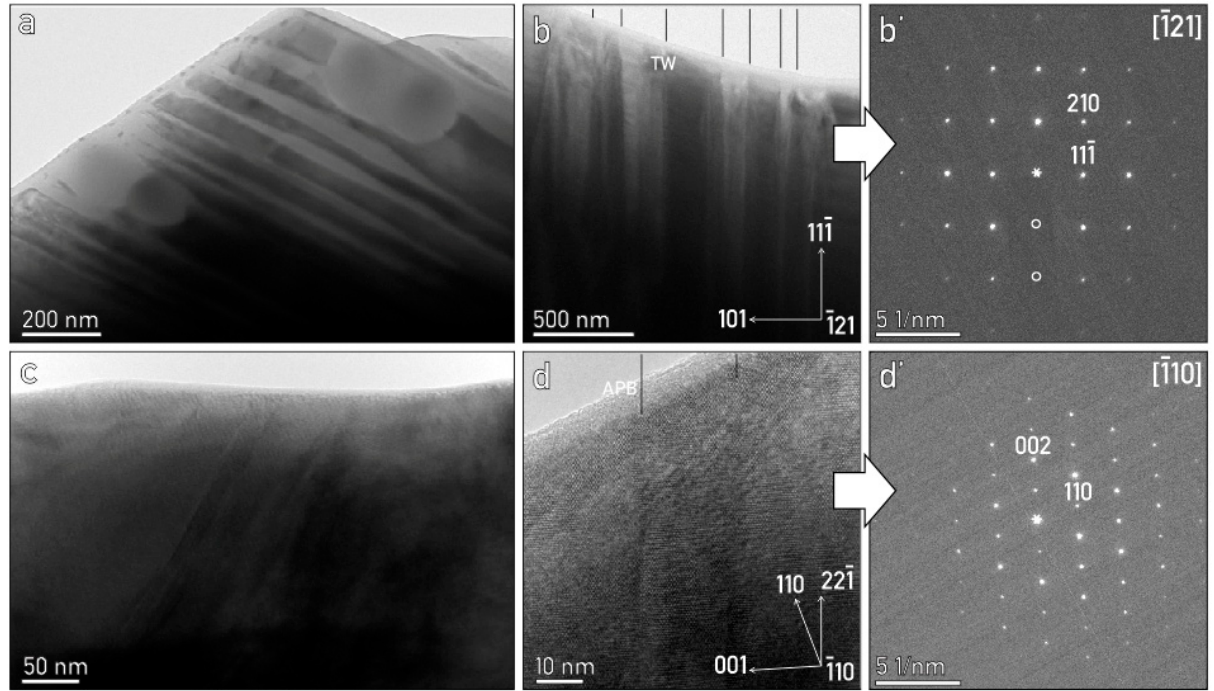
Figure 5. ( a , c ) Overview TEM micrograph of multiple parallel planar defects in single-crystal arsenopyrite. ( b ) Crystal viewed in [ − 121], showing {101} twin lamellae and corresponding ( b’ ) SAED pattern; reflections masked by beam stopper are marked by white circles. ( d ) Arsenopyrite viewed in [ − 110] with antiphase domain boundary (APB) and corresponding ( d’ ) SAED pattern.